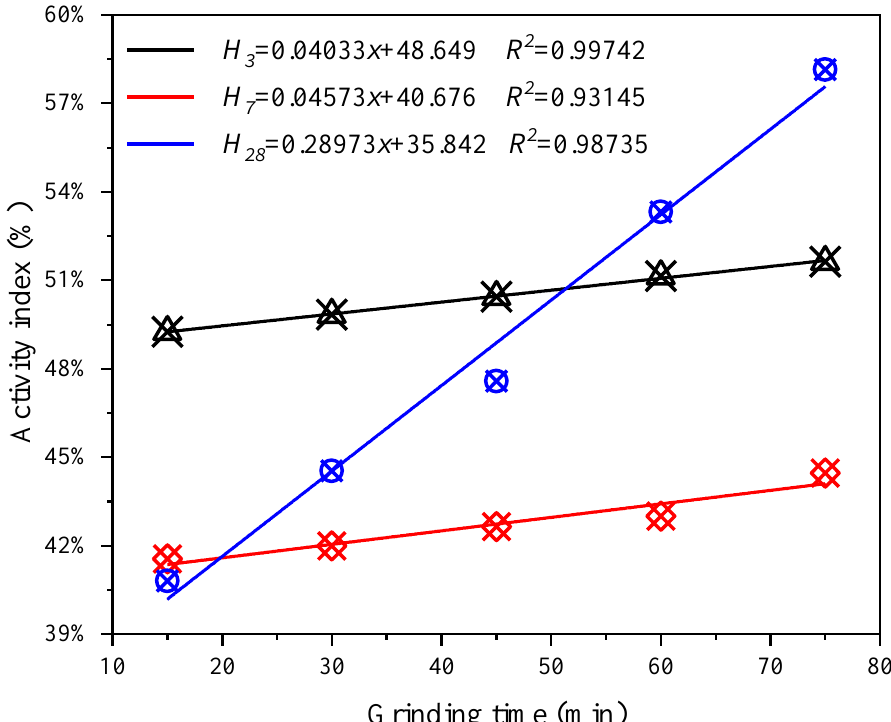
Figure 12. Relationship between activity index of CGS and grinding time. Table 6. Grey correlation between particle group of CGS and strength activity